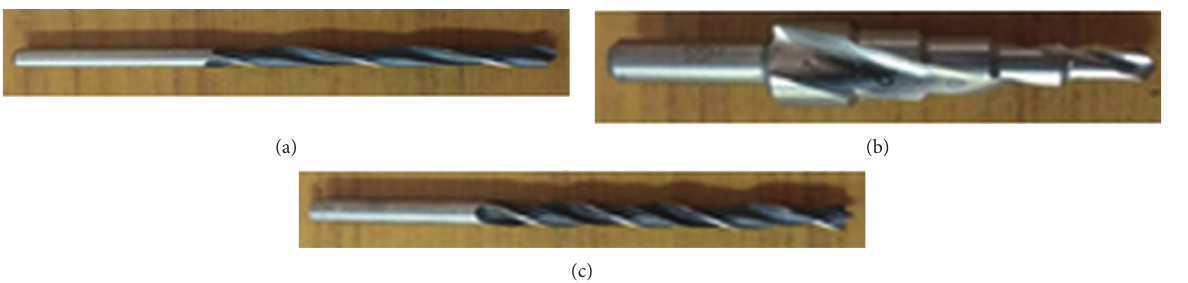
Figure 3: (a) Standard twist drill, (b) step cone drill, and (c) candlestick drill tools.